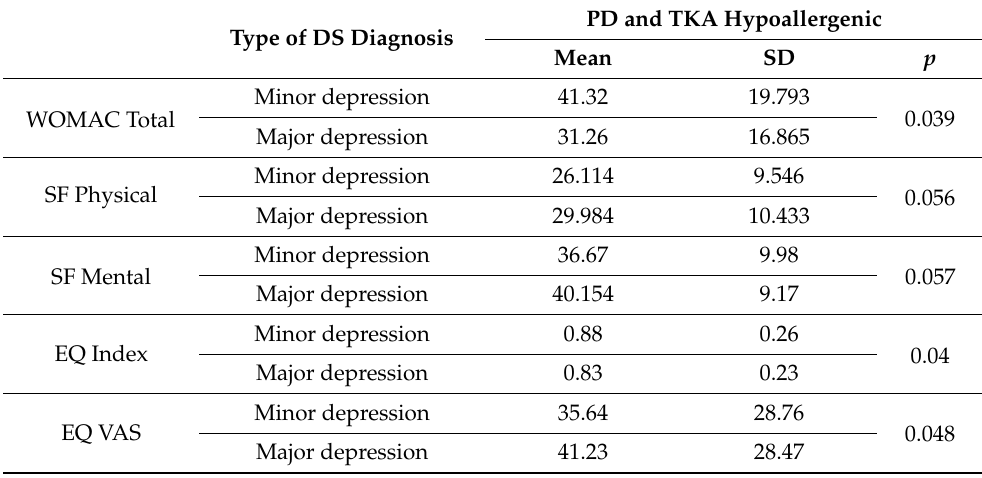
Table 6. Student t results for independent samples of preoperative hypoallergenic psychological dis- tress and TKA and diagnosis of minor depression/dysthymia/anxiety or major depression/psychotic disorder with respect to the results of the questionnaires (WOMAC, SF-12, and Euro- Qol-5D). PD and TKA Type of DS Diagnosis